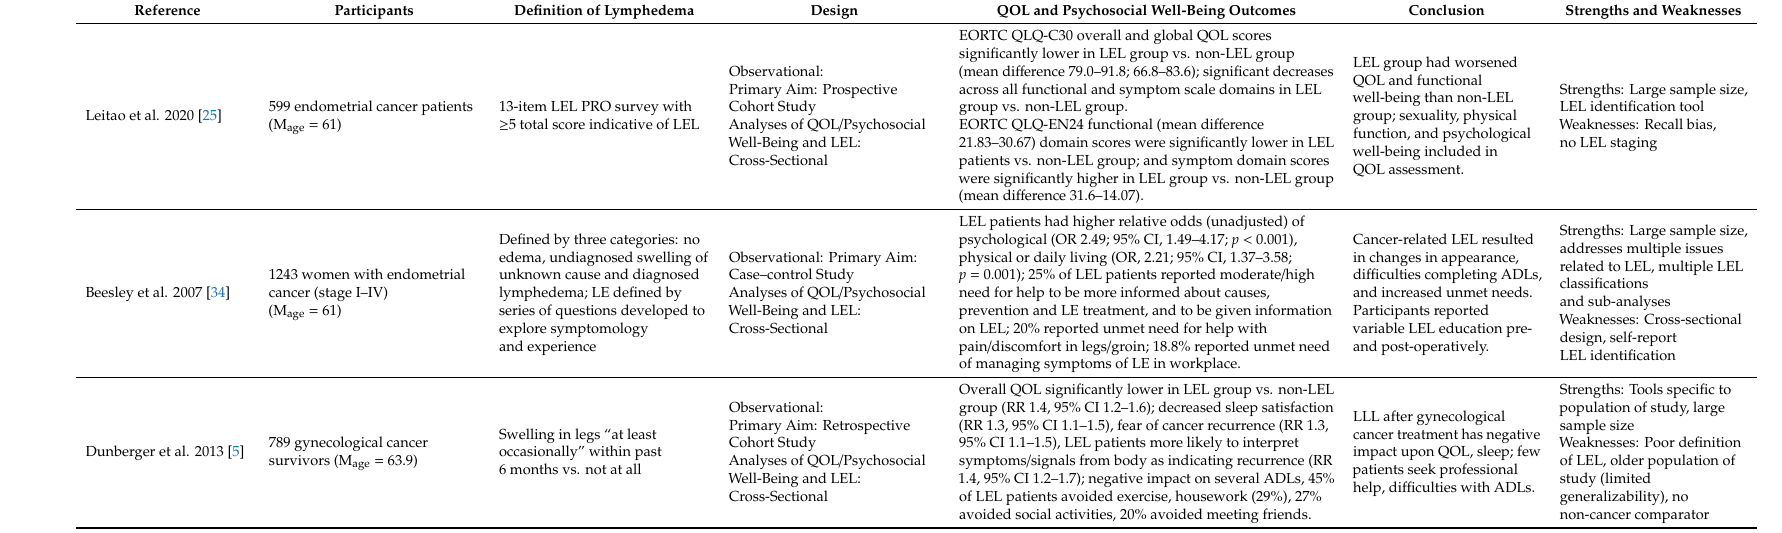
Table 1. Psychosocial LEL Study Data